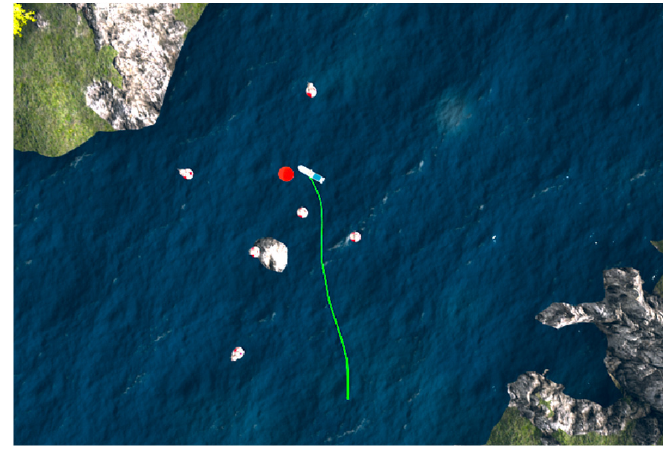
Figure 11. Platform training result.